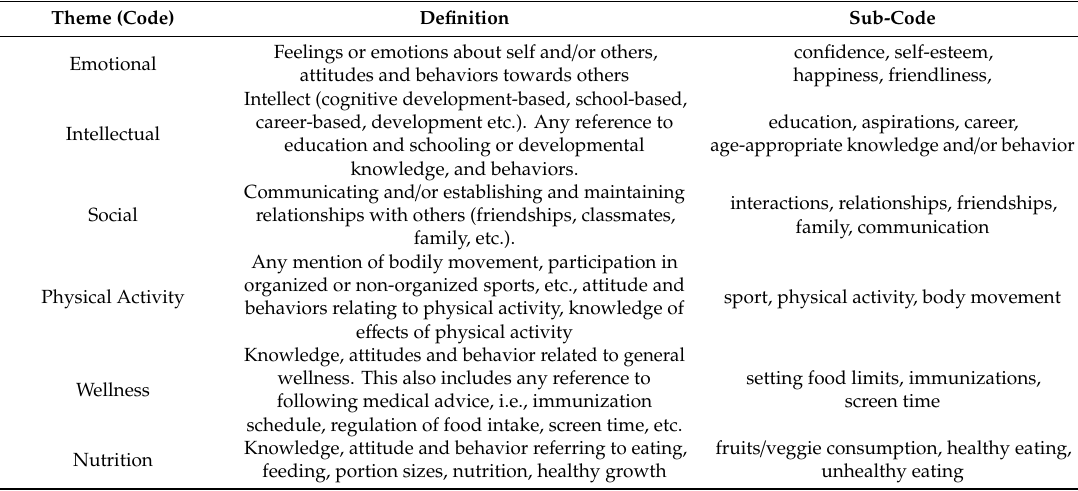
Table 1. Theme / Code Definitions.